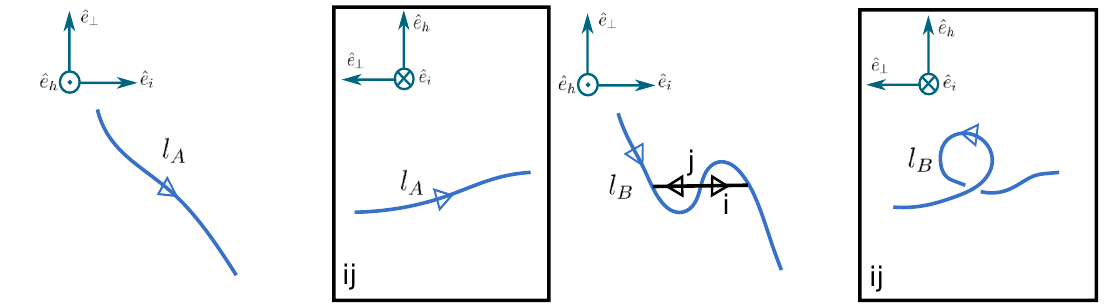
Figure 50 . The (cid:12)rst Reidemeister move. Here ^ e h is the unit vector along the height direction and ^ e i is the unit vector along the i -orientation of ij